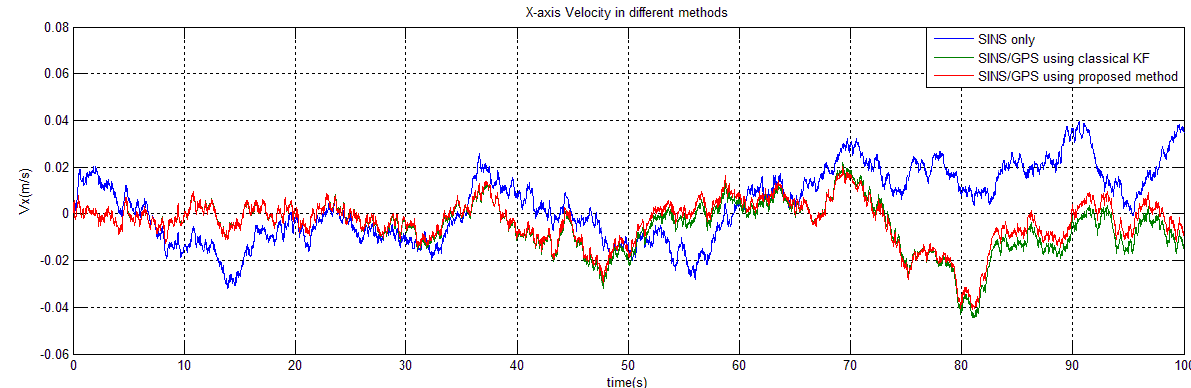
Figure 4. Velocity calculation by different